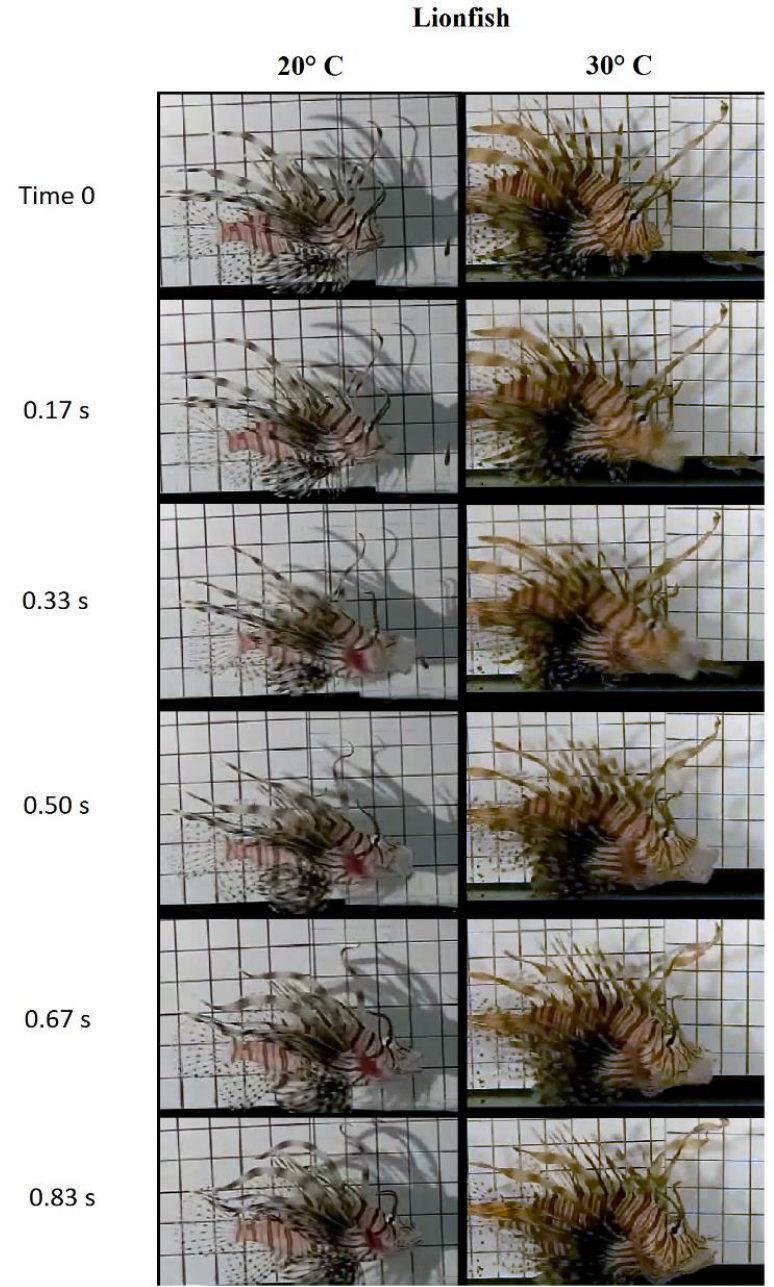
Figure 3. Select frames of representative films of two lionfish showing the sequence of kinematic events during prey capture in lionfish, Pterois volitans , at 20 °C, and 30 °C. Note that all species of invasive fishes successfully captured prey in both temperatures.